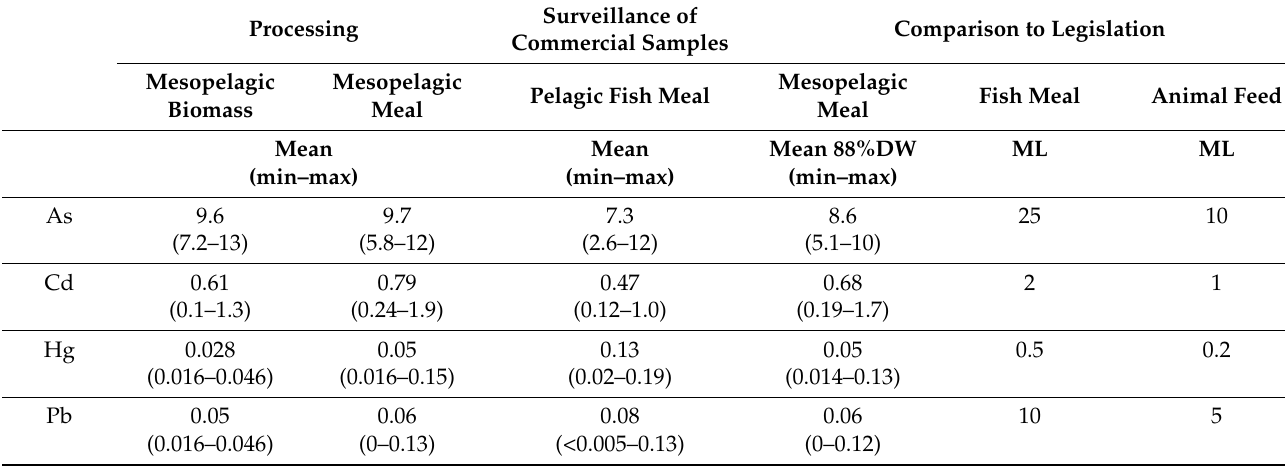
Table 2. Concentrations of the trace elements, arsenic (As), cadmium (Cd), mercury (Hg), and lead (Pb) in mg kg − 1 dry weight (DW) (mean, (minimum–maximum), n = 4) in the raw mesopelagic biomass the concentration in processed mesopelagic meal (DW), commercial pelagic fish meals (n = 9), and mesopelagic meal expressed as 88% DW. For comparison, the maximum limits (ML) given in EU Directive 2002/32/EC is given for fish meals and animal